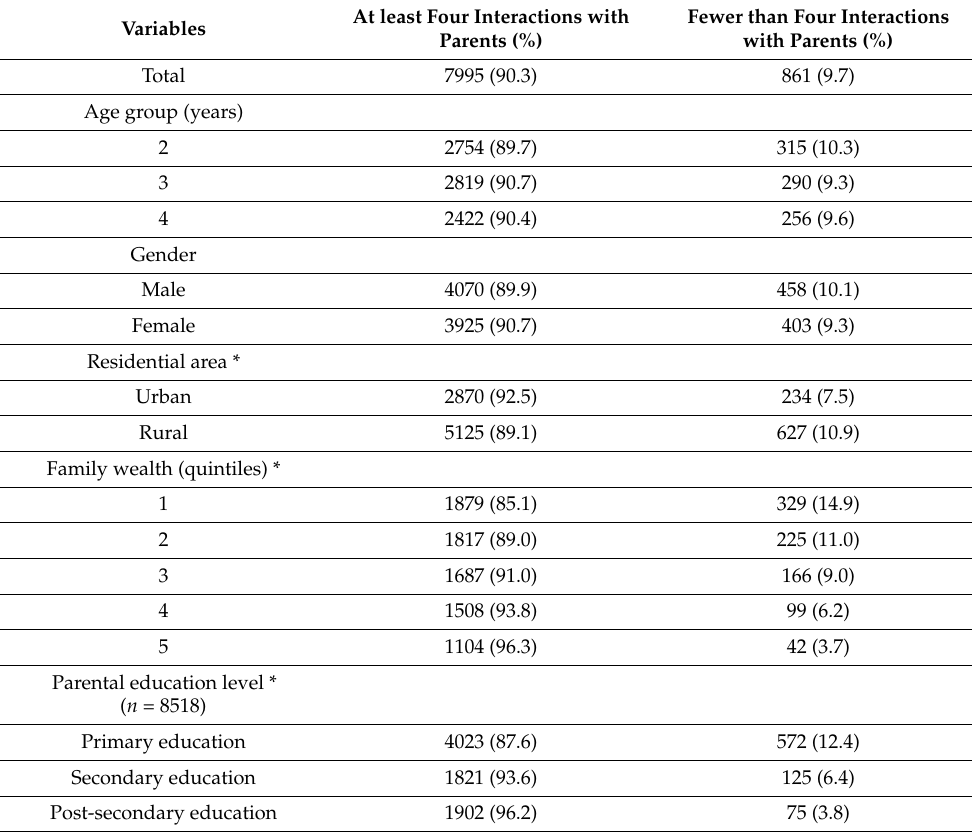
Table 1. Comparing the parental interactions by children’s attributes. At least Four Interactions with Fewer than Four Interactions Variables Parents (%) with Parents